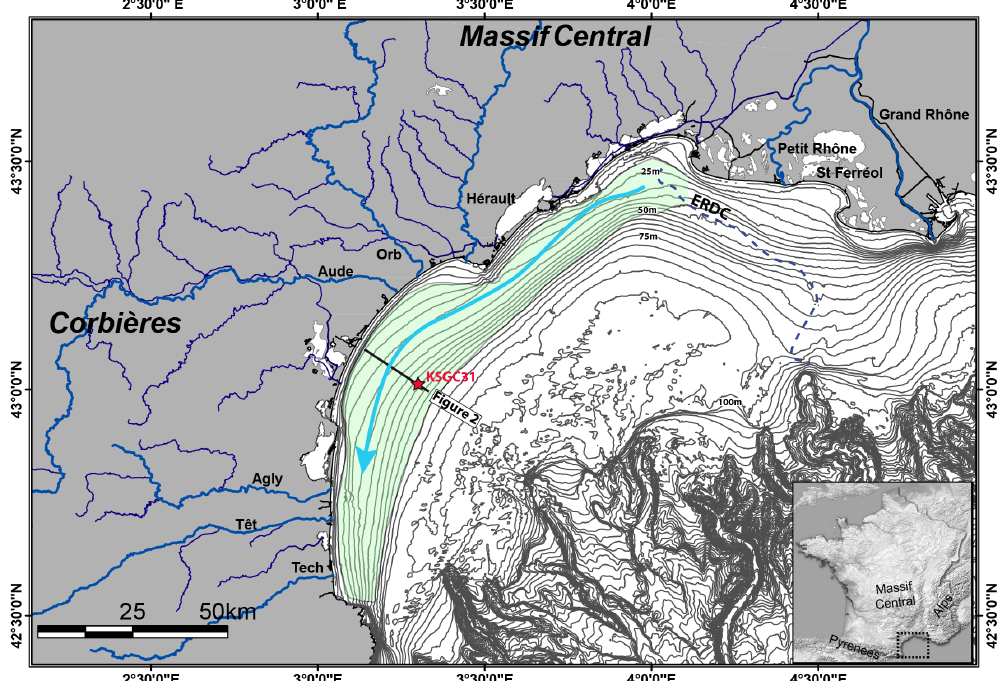
Figure 1. Bathymetric map of the Gulf of Lions and position of core KSGC31. The approximate extent of the Rhône mud belt is represented in green; the arrow represents the direction of dominant transport of suspended sediments. Bathymetric map based on Berné et al. (2007). Contour lines every 5m on the shelf. The dotted line corresponds to the retreat path of the Rhône during the deglacial period (based on Gensous and Tesson, 2003; Berné et al., 2007; Jouet, 2007; Fanget et al., 2014; Lombo Tombo et al., 2015). ERDC: Early Rhône Deltaic